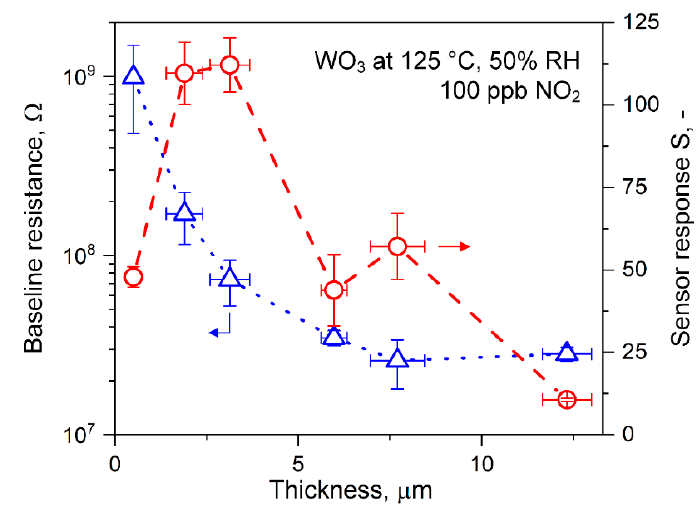
Figure 4. Effect of film thickness on sensor response. Baseline resistance (triangles) for flame-deposited WO 3 films at 125 °C and 50% relative humidity (RH) (at 23 °C) and corresponding sensor responses to 100 ppb NO 2 (circles). Symbols indicate the averages, and vertical error bars the corresponding variabilities of three identically produced sensors. Horizontal error bars represent the thickness variability of a sensing film (of 40 measurements).